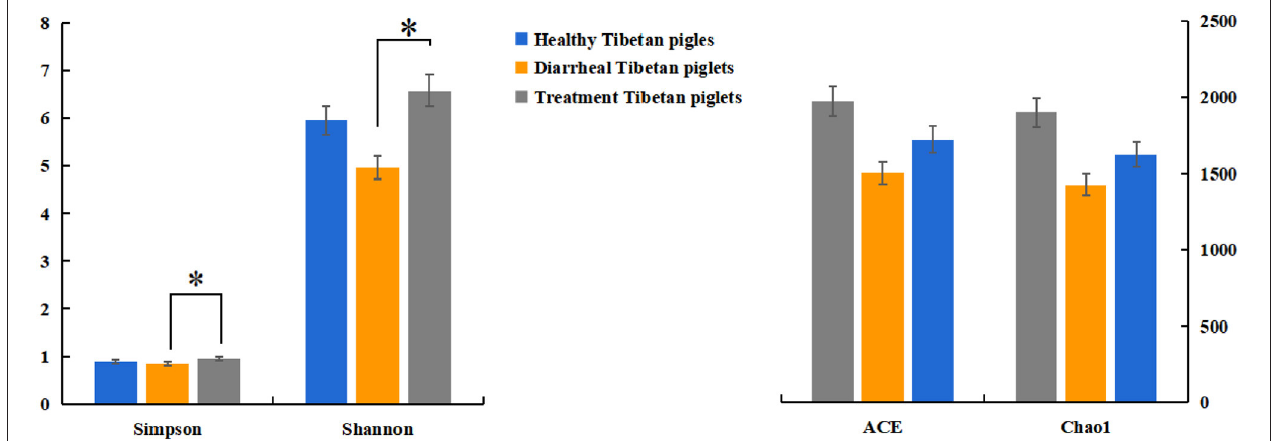
FIGURE 2 | Diversity indices of the fecal microbiota in different Tibetan piglets. Chao1, ACE, Shannon, and Simpson indices were used to evaluate the alpha diversity of the fecal microbiota. The results were evaluated through one-way ANOVA. All of the data represent means ± SD. * p <